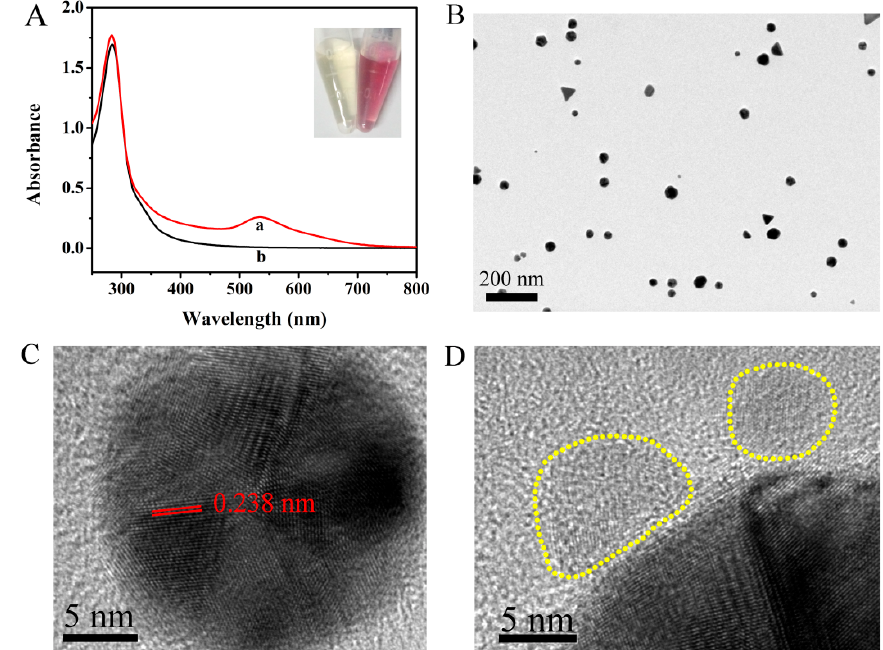
Figure 2. ( A ) UV-vis spectra of CQDs/AuNPs (a) and CQDs (b). Inset: photographs of CQDs (left) and CQDs/AuNPs (right); ( B ) TEM of CQDs/AuNPs; ( C , D ) high-resolution TEM (HRTEM) of CQDs/AuNPs.